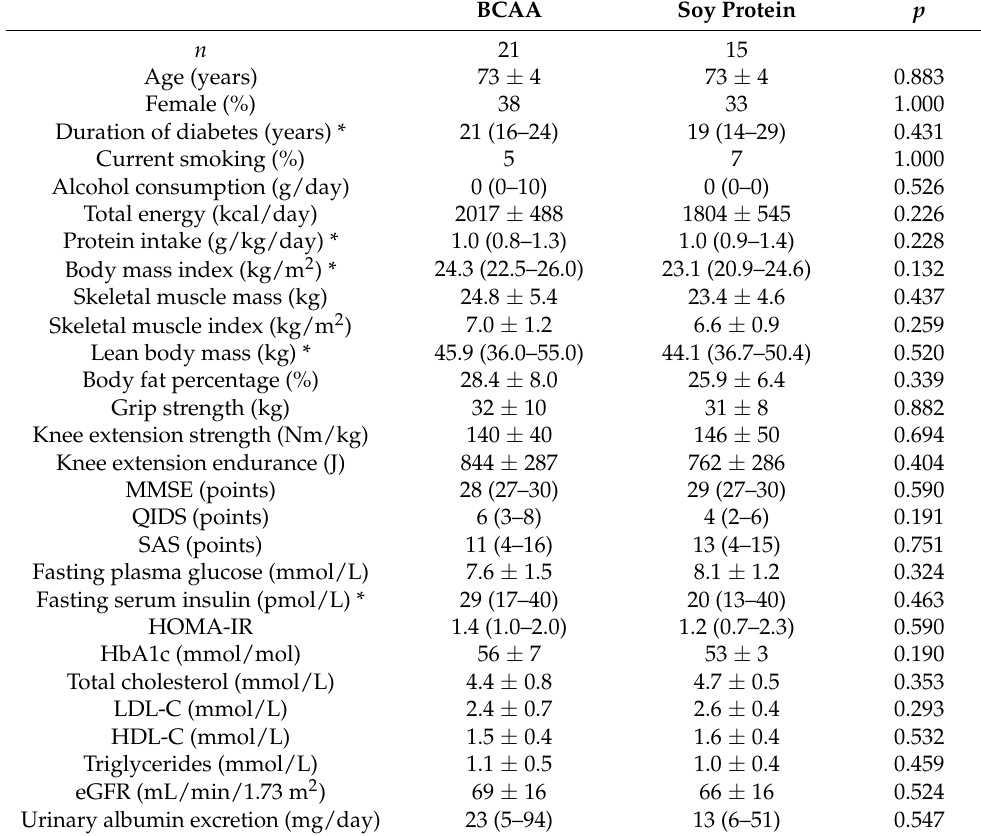
Figure 1. Flow chart of study participants. Participants ( n = 38) were randomly assigned to the branched-chain amino acids (BCAA) group and the soy protein group based on minimization methods considering sex, age, and baseline HbA1c. Participants who were assigned to the soy protein group at first received BCAA supplement by accident and were finally assigned to the BCAA group. Table 1 shows the baseline characteristics of the participants. Baseline characteristics between the BCAA group and the soy protein group were not significantly different except for the number of participants taking glinides (0% in the BCAA group vs. 33% in the soy protein group, p = 0.008). Table 1. Baseline clinical characteristics of study participants.